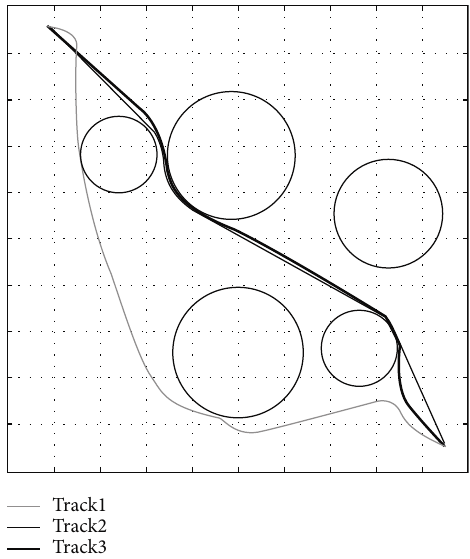
Figure 11: Path 2 covered by volcanic